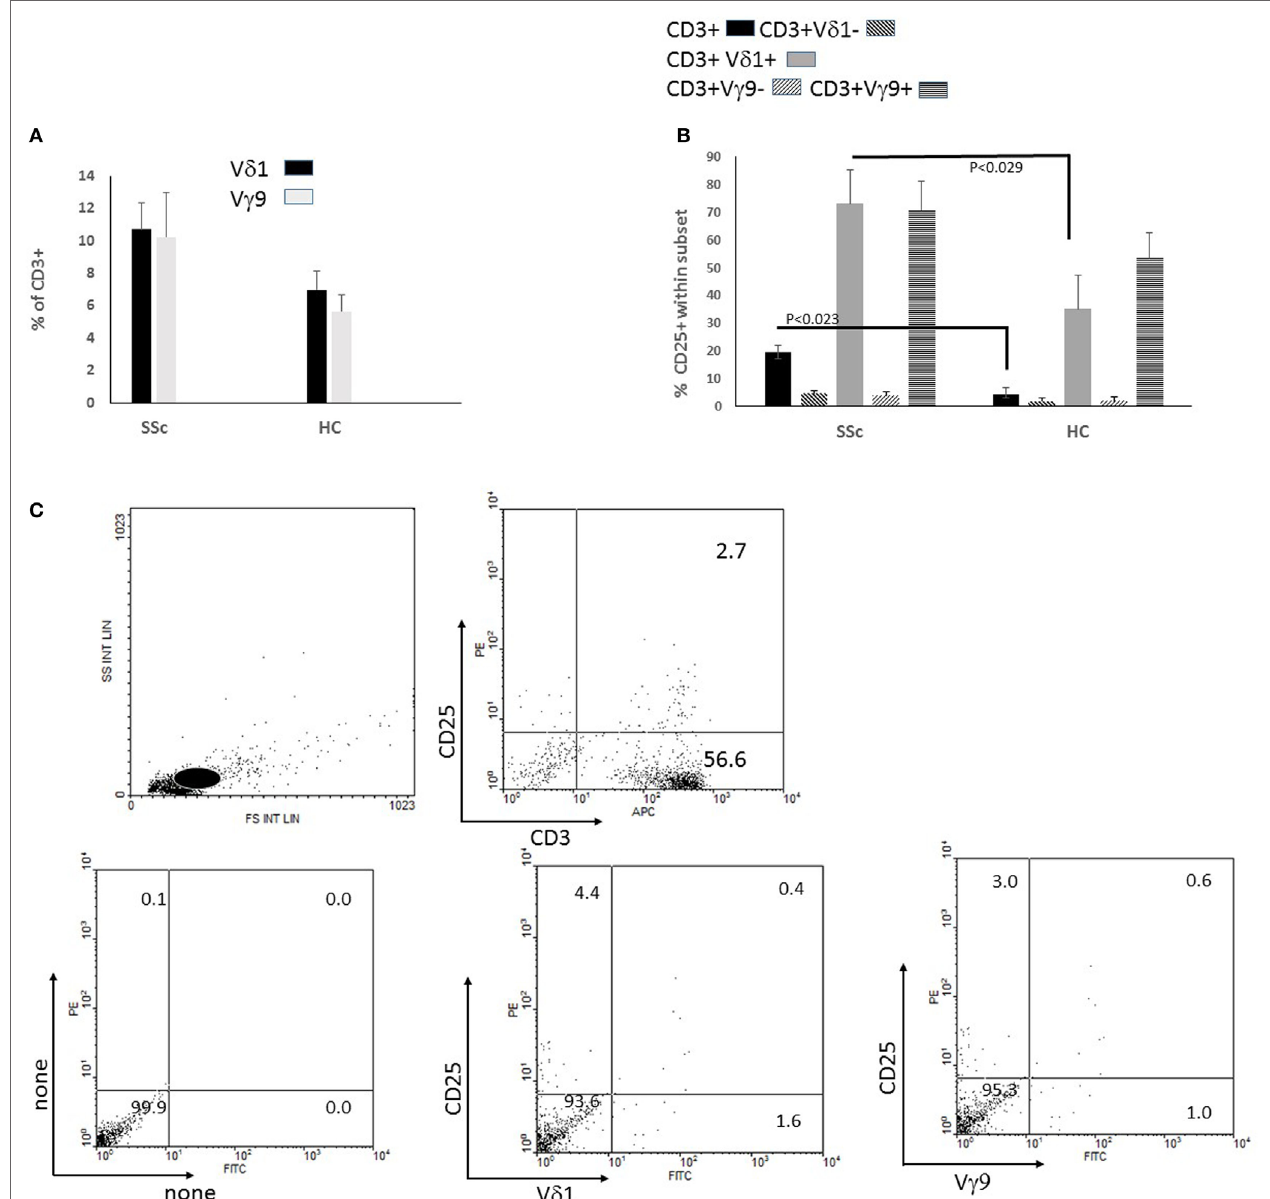
FigUre 1 | Percent of CD25 + cells in cultures of peripheral blood mononuclear cells (PBMCs) from patients with systemic sclerosis (SSc) vs healthy controls (HCs). PBMCs of 12 SSc patients (patients 1–12 in Table 1 ) and 8 HCs were incubated in medium alone for 4 days and then stained for flow cytometric analysis with fluorochrome-labeled monoclonal antibodies (mAbs) anti-CD25-PE, anti-V δ 1-FITC, anti-V γ 9-FITC, and anti-CD3-APC. (a) Data for the anti-V δ 1-FITC, anti-V γ 9-FITC staining of T cells in the cultures obtained by gating on CD3 + cells as shown in (c) . (B) Results for percent of cells within each of indicated subsets that were stained with anti-CD25-PE in (B) calculated as indicated in Section “Materials and Methods.” Bars represent the mean and SEMs. Significant differences between means by two-tailed Student t -test are indicated. (c) Dot plots represent on the upper left forward and side scattergram. The Lymphocyte gate is indicated with a white circle. On the upper right, dot plots of cells within the lymphocyte gate were stained with mAb to CD3 and CD25. The lower panel shows dot plots of cells within the gated CD3 + population unstained on the left, or with mAb to V δ 1 or V γ 9 bound to FITC, and CD25-PE as